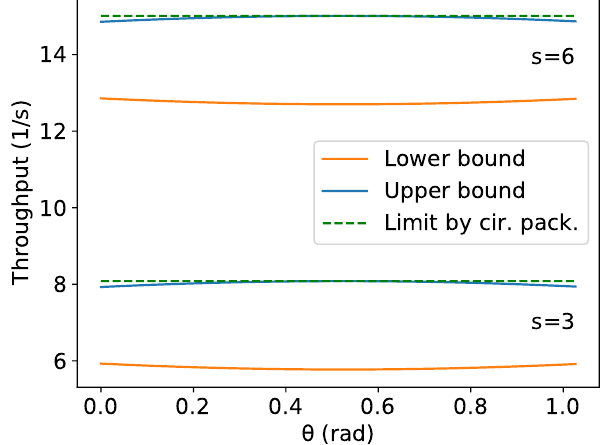
Figure 7. Limit given by (8) using the circle packing results and the lower and upper bounds of the hexagonal packing limit by (11) for θ ∈ [0, π / 3), d = 1 m, v = 1 m/s and s ∈ { 3,6 }